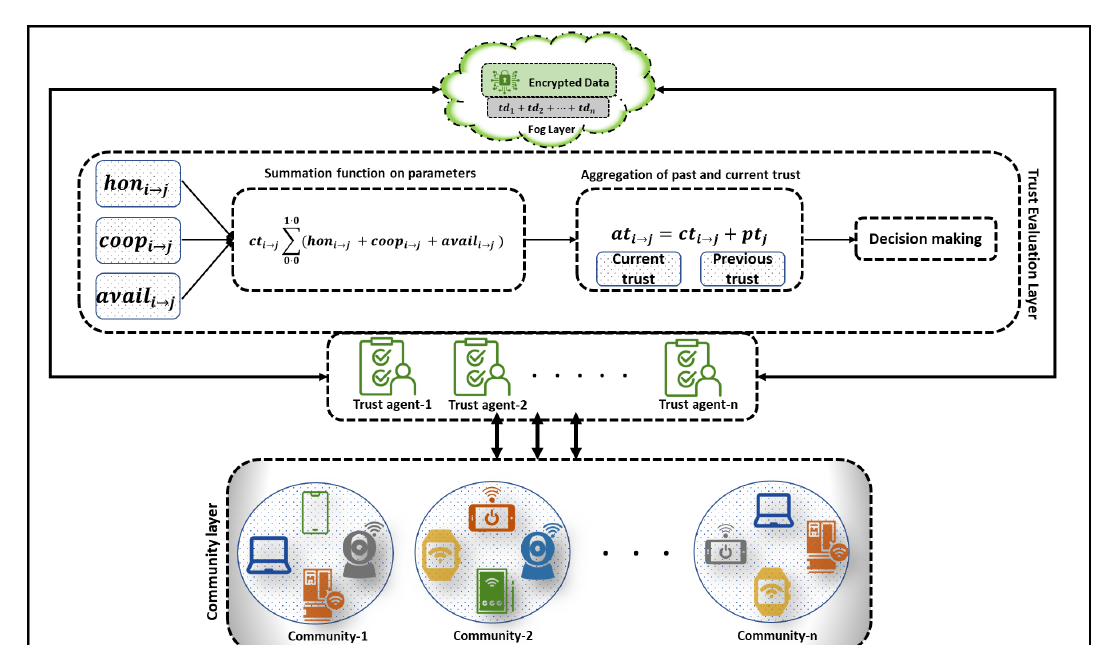
Figure 1. The proposed FogTrust